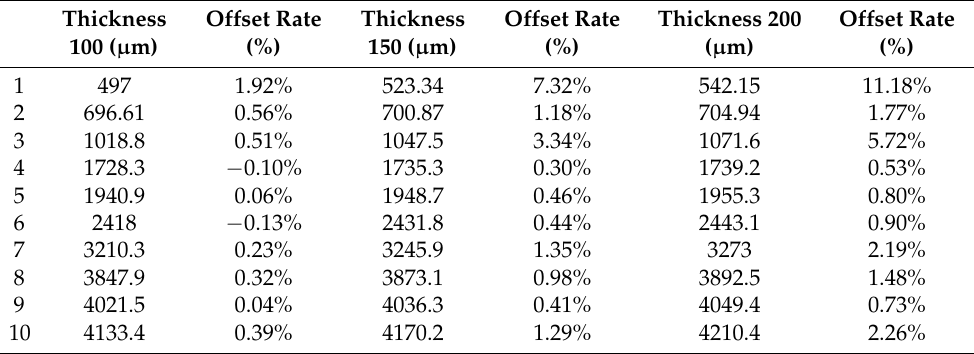
Table 7. First 10 natural frequencies/Hz of galvanized steel clamps coated with different thicknesses of Z r O 2